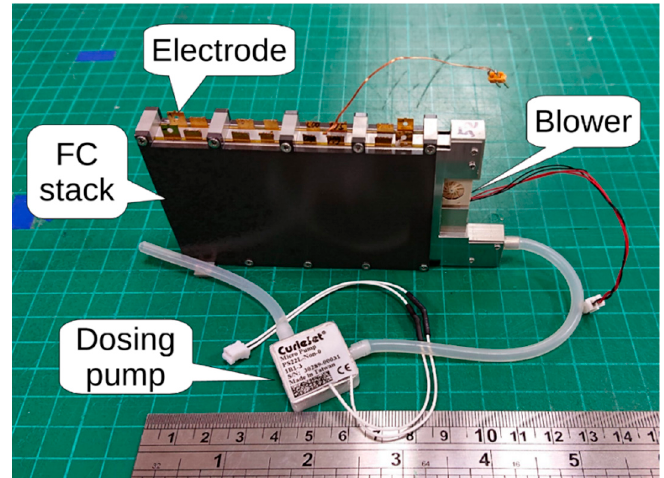
Figure 2. Semi-active DMFC stack module.